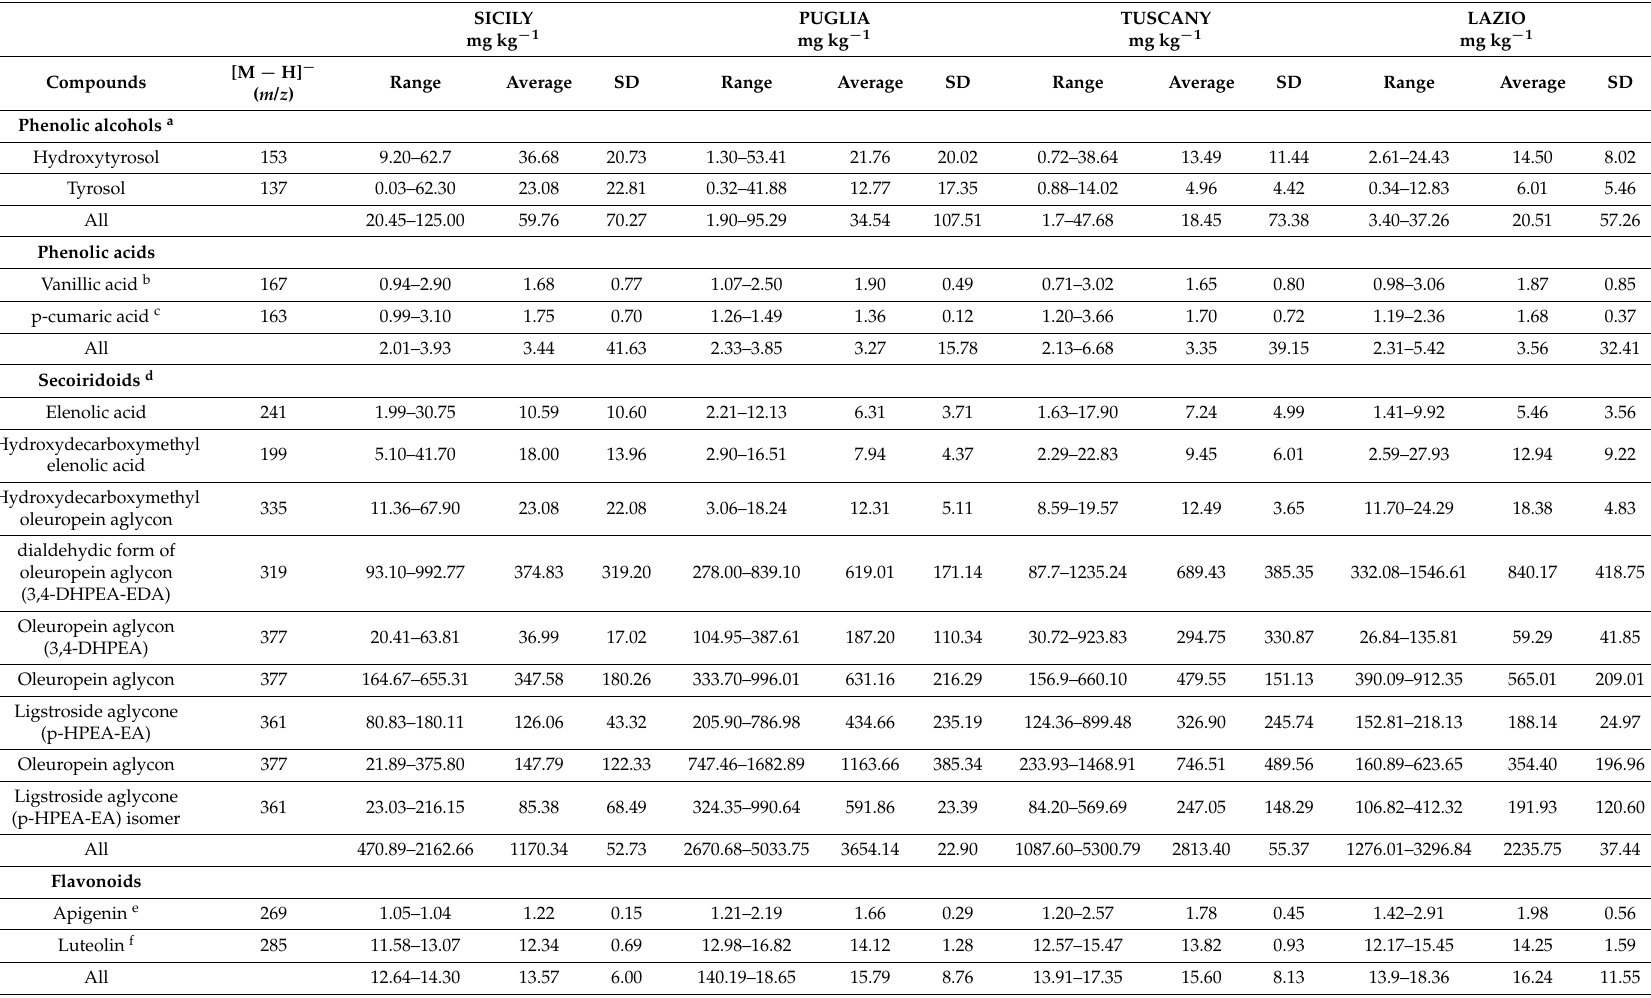
Table 1. Mean, minimum, and maximum concentration (expressed as mg kg − 1 of oil) of phenolic compounds found in EVOO samples produced in the four different Italian